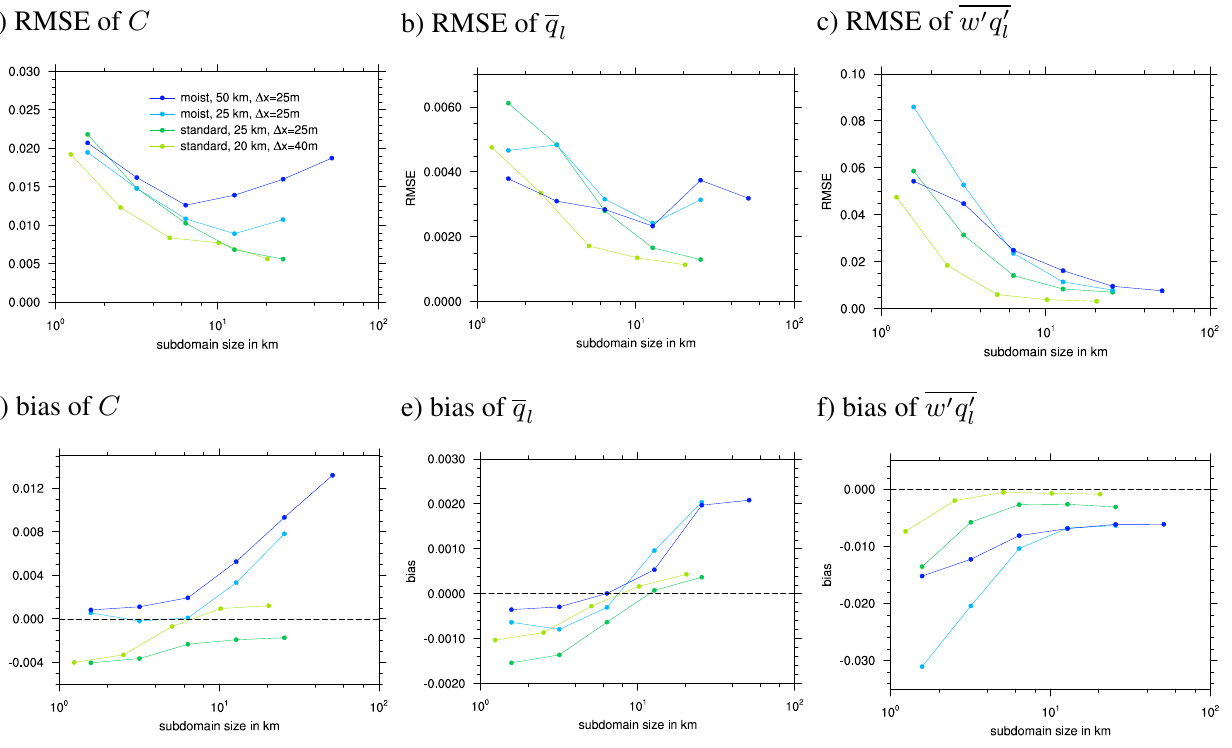
Fig. 8. Dependence of the error of the parameterized cloud fraction, liquid water and liquid water flux on the domain size. Shown are different simulations of the RICO case (average error over two output time steps after 24h); in the moist RICO cases mesoscale structures develop, while in the standard cases the cloud field remains random.